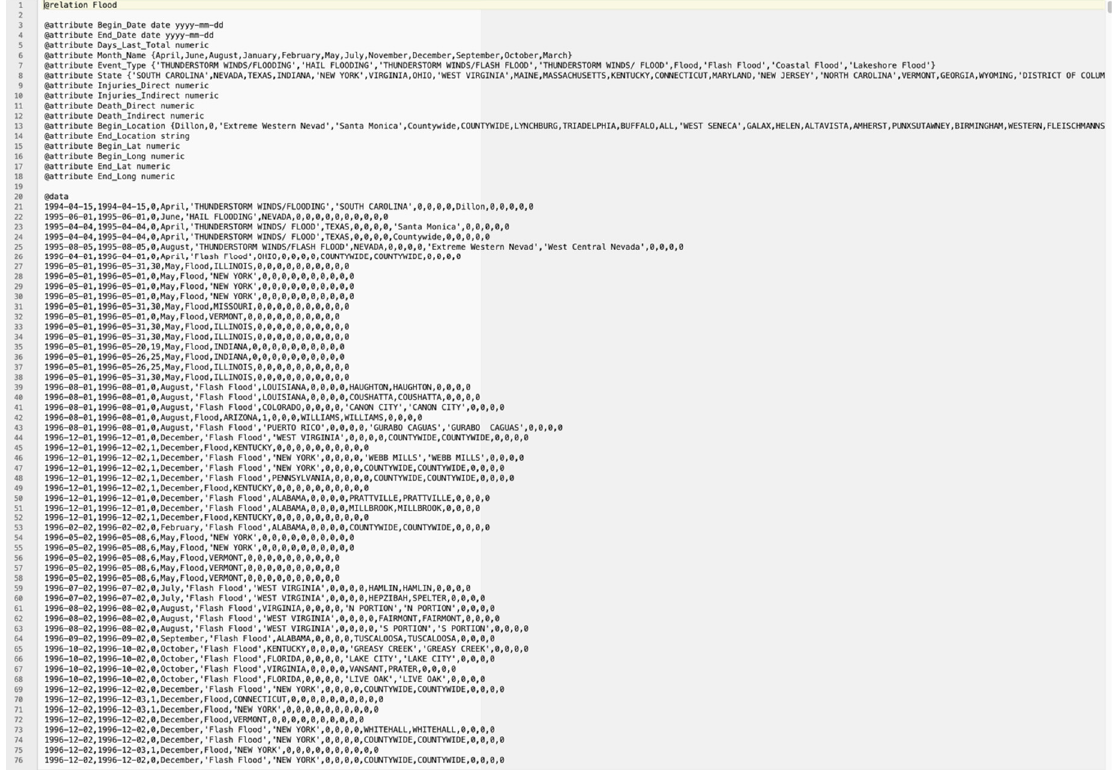
Figure 3. A sample of input data prepared for training.